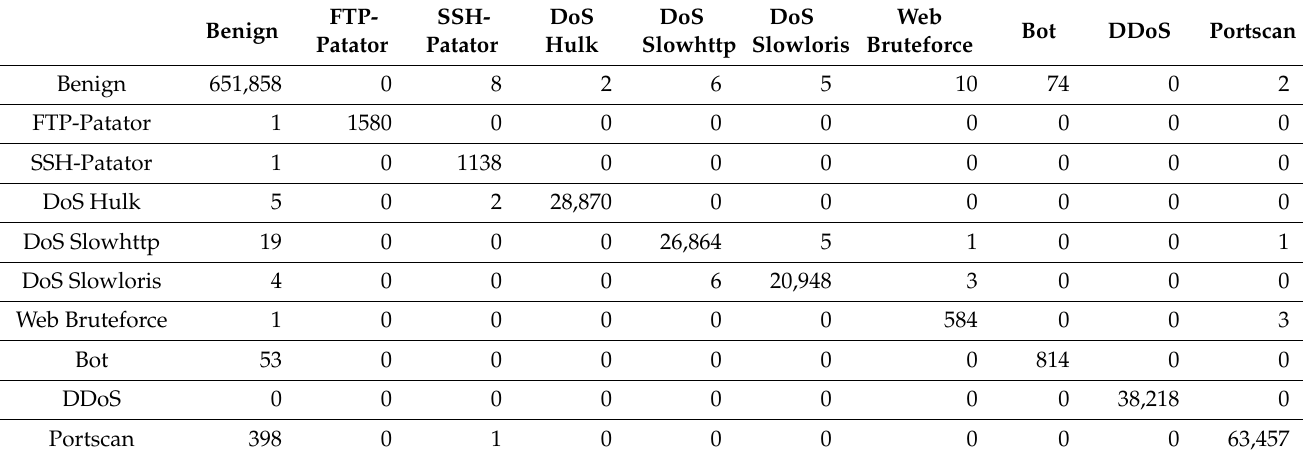
Table 8. Confusion matrix for DTKNN using the single-host